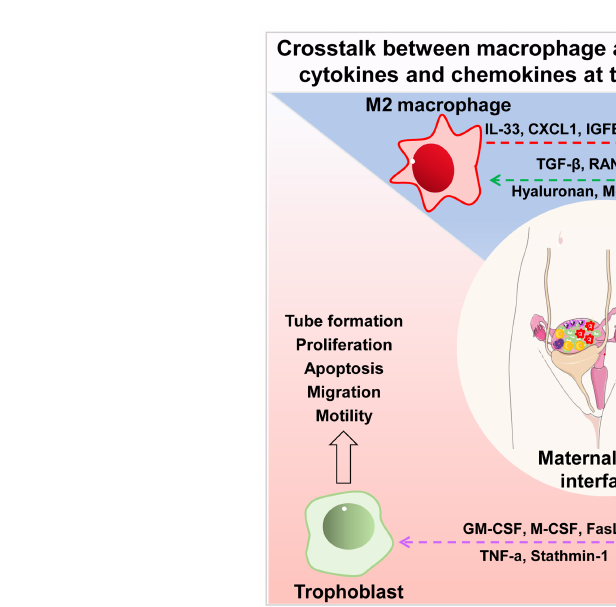
FIGURE 1 | Crosstalk between macrophage and trophoblast mediated by cytokines and chemokines at the maternal-fetal interface. Cytokines and chemokines secreted by M2 macrophages (IL-33, CXCL1, IGFBP1, G-CSF, TGF- b , Wnt5a) regulate the proliferation, apoptosis, invasion and migration of trophoblast via PI3K/ AKT/Erk1/2, MAPK/ERK and p42/44 MAPK signal pathways. Trophoblast- derived secretory factors (TGF- b , RANKL, CXCL16, IL-34, hyaluronan, M-CSF, IL-10, PD-L1, IL-6) drive M2 macrophage polarization in turn. Soluble molecules secreted by M1 macrophages (GM-CSF, M-CSF, FasL, TNF-a, Stathmin-1) in fl uence the tube formation, proliferation, apoptosis, migration and motility of trophoblast. IL, interleukin; CXCL, chemokine (C-X-C motif) ligand; IGFBP1, insulin-like growth factor-binding protein-1; G-CSF, granulocyte colony stimulating factor; TGF- b , transforming growth factor b ; RANKL, receptor activator of NF- k B ligand; M-CSF, macrophage colony stimulating factor; PD-L1, programmed cell death 1 ligand 1; GM-CSF, granulocyte-macrophage colony stimulating factor; FasL, factor associated suicide ligand; TNF- a , tumor necrosis factor a